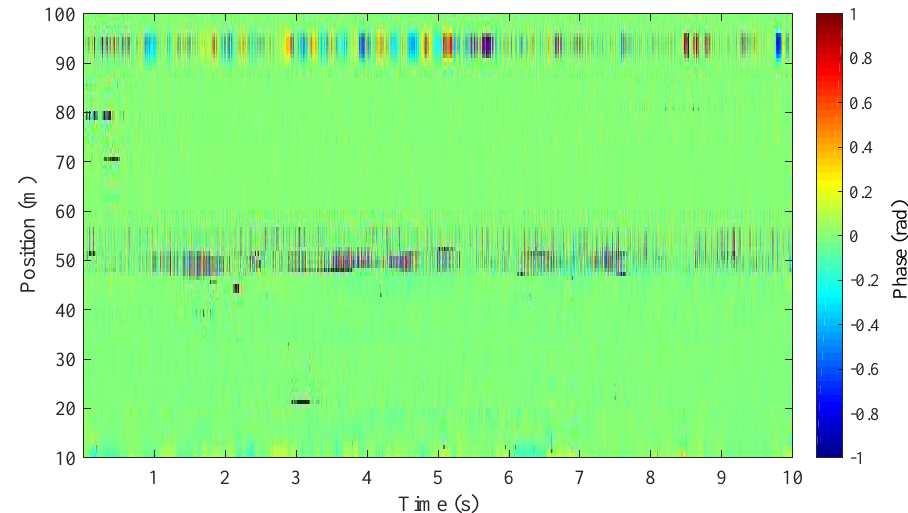
Figure 11. Waterfall plot of the detected phase signal for the music.